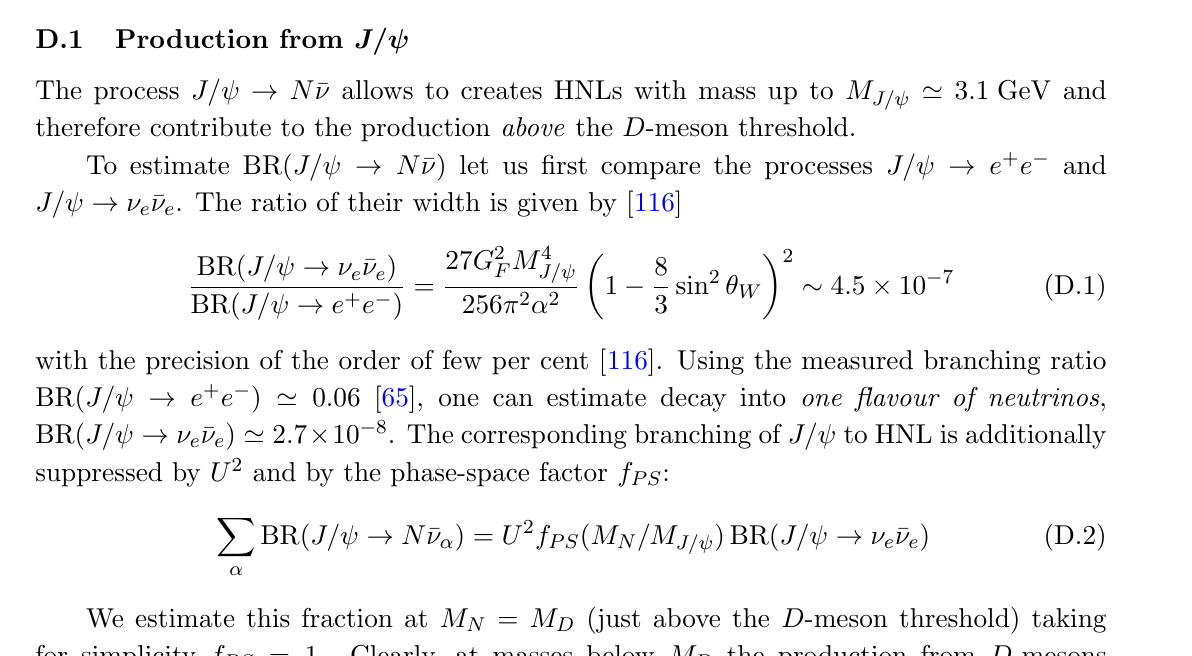
are taken from [65], while for B (cid:3) theoretical s c